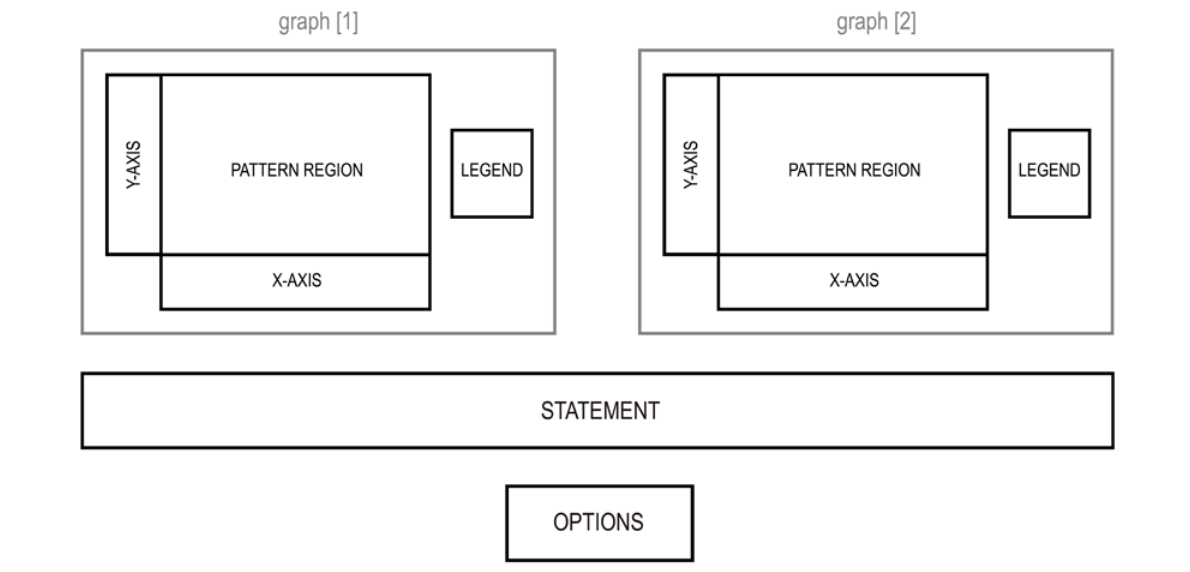
Figure 2. Composition of Areas of Interest (in capital letters) defined for the eye-tracking